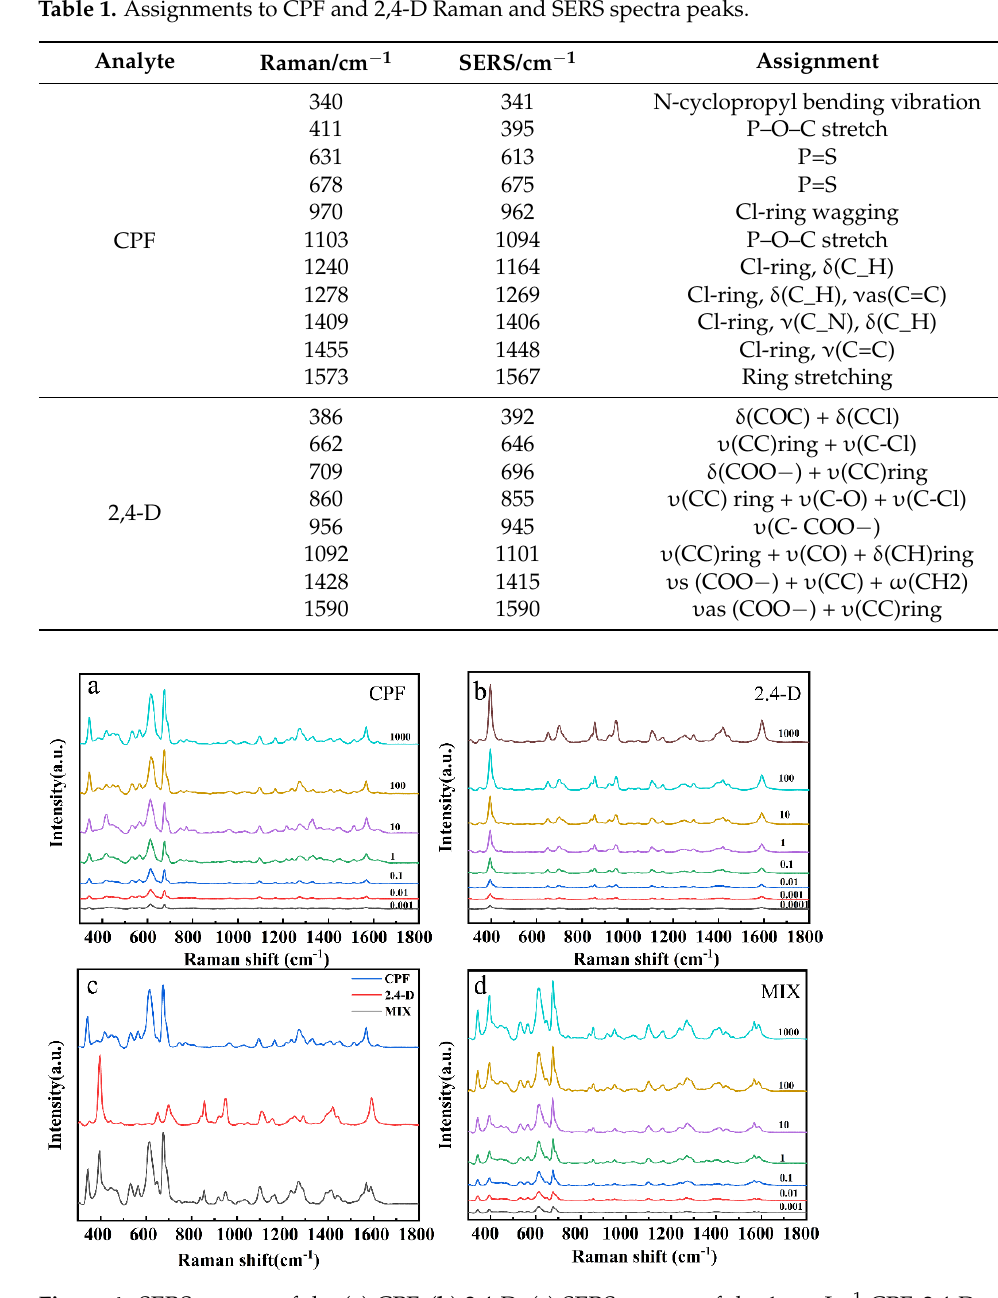
Figure 4. SERS spectra of the ( a ) CPF, ( b ) 2,4-D, ( c ) SERS spectra of the 1 mg L − 1 CPF, 2,4-D and mixed standard solution, ( d ) mixed standard solution. Table 1. Assignments to CPF and 2.4 − D Raman and SERS spectra peaks.